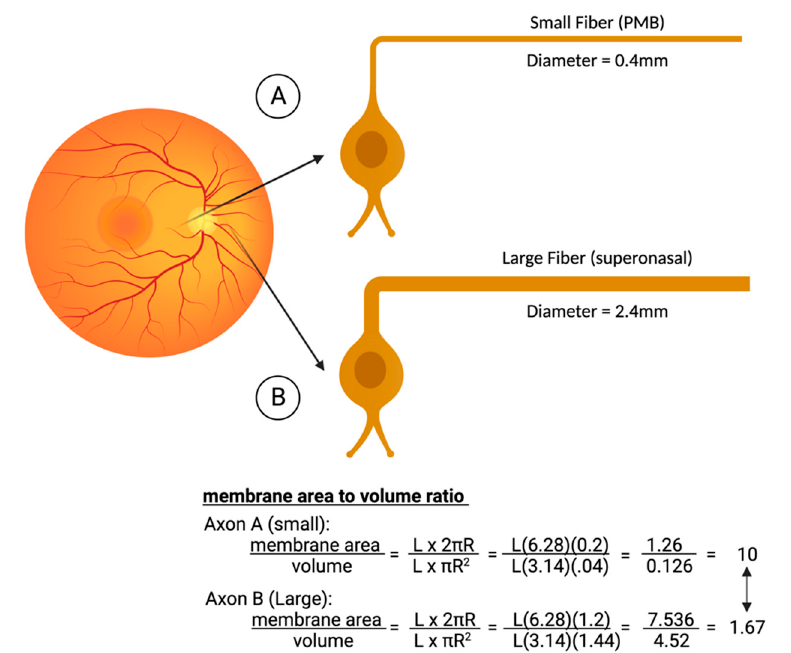
Figure 3. Comparison of the metabolic strain in smaller axons that are concentrated in the papillo- macular bundle (PMB). The smaller fiber ( A ) typically has a diameter of only 0.4 microns. Compared to the larger fibers of the nasal retina ( B ), the PMB fiber has a much-reduced volume and hence fewer mitochondria. Although its surface area is a little less as well, the area/volume ratios are six times worse in the smaller fibers, explaining why they are the first to die in LHON. Figures created with biorender.com.